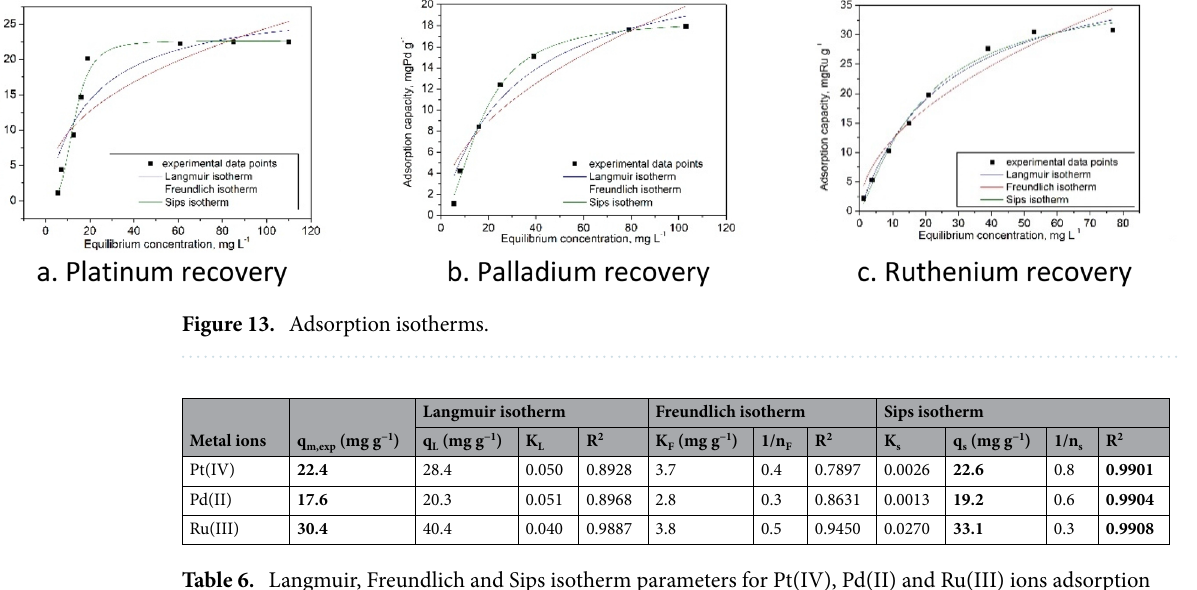
Table 6. Langmuir, Freundlich and Sips isotherm parameters for Pt(IV), Pd(II) and Ru(III) ions adsorption onto Ch-DB18C6 material.